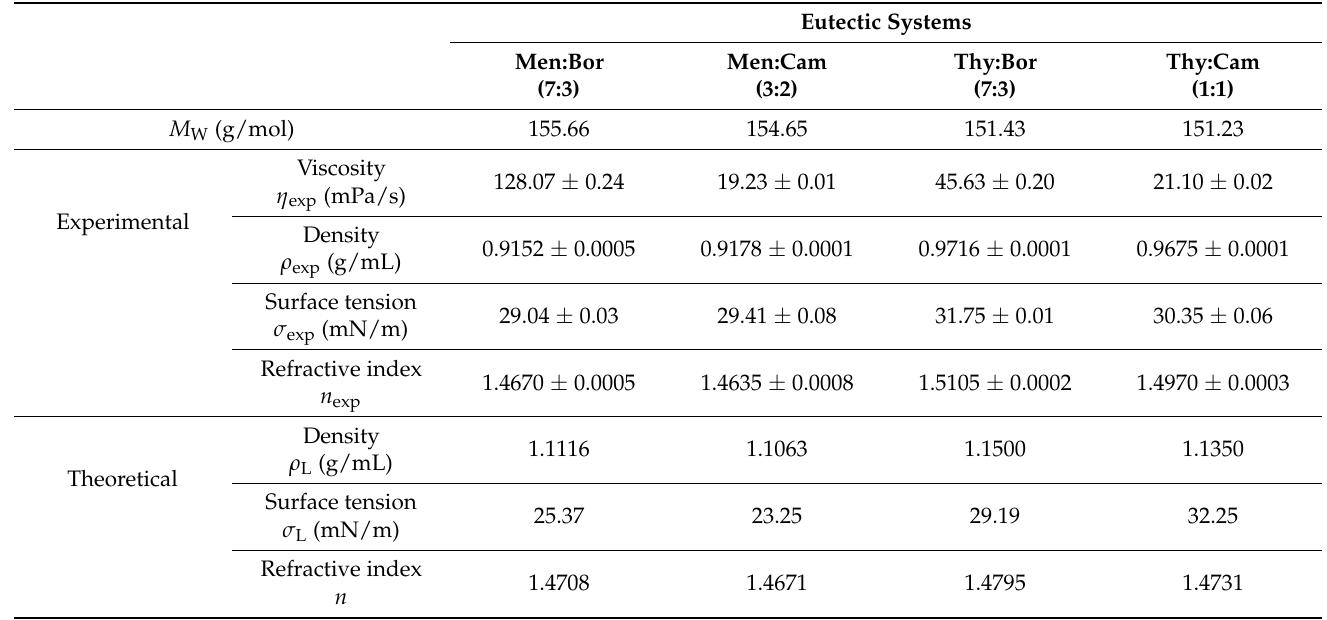
Table 2. Experimental and theoretical properties of the eutectic